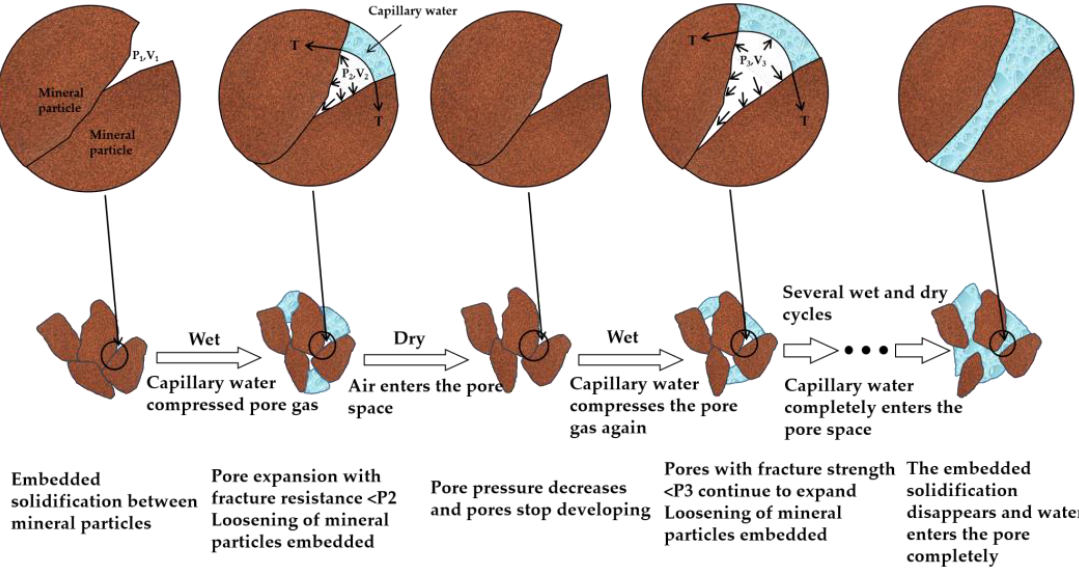
Figure 2. Air pressure fracturing of red-bedded soft rock with dry–wet cycles.